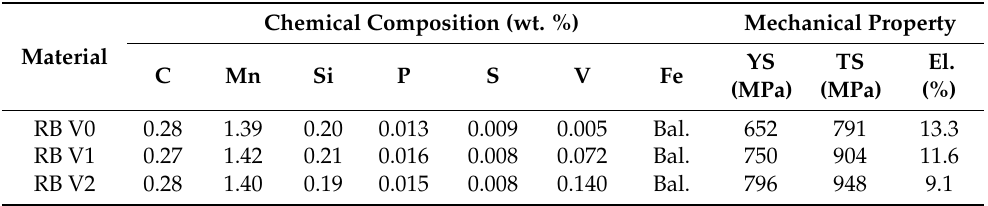
Table 1. Chemical composition and mechanical properties of rebars.